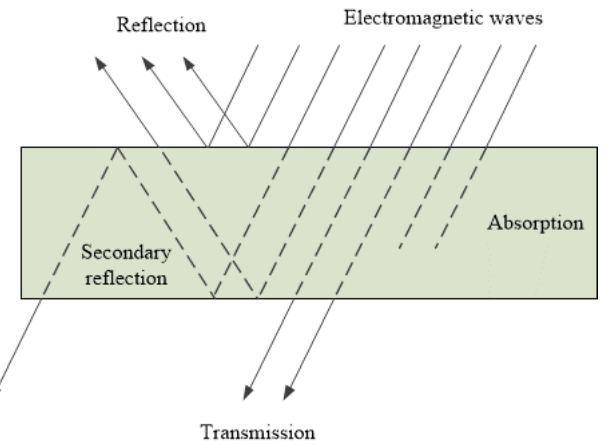
Figure 1. Schematic presentation of the signal propagation through a material with protective properties.